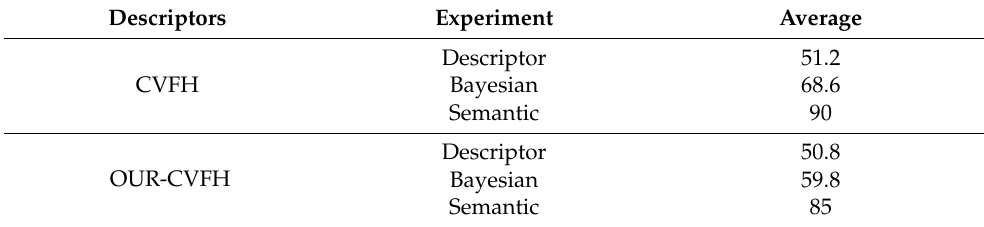
Table 5. Average of recognition per Object and methods for all descriptors, represented in a